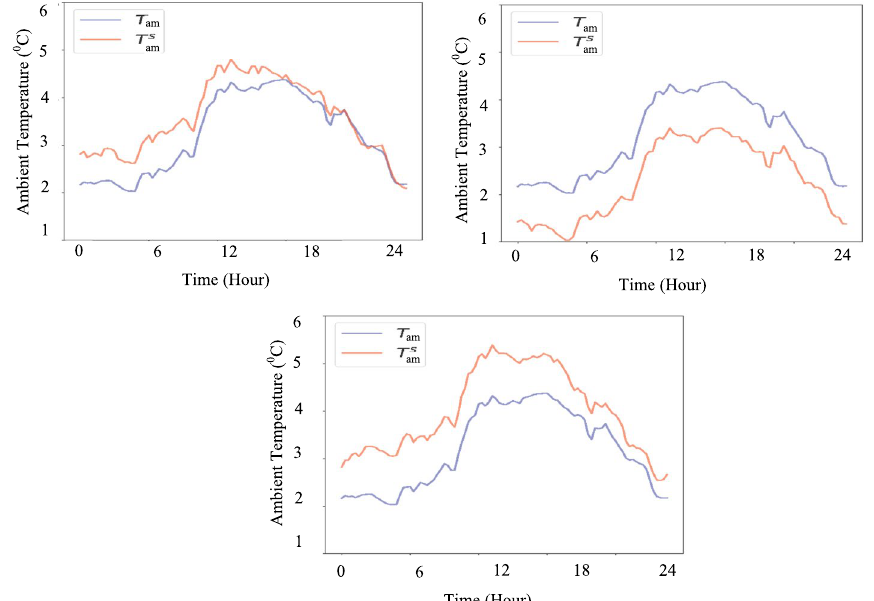
Fig. 4 Example of three different outdoor ambient temperature trends obtained starting from the same weather forecast data